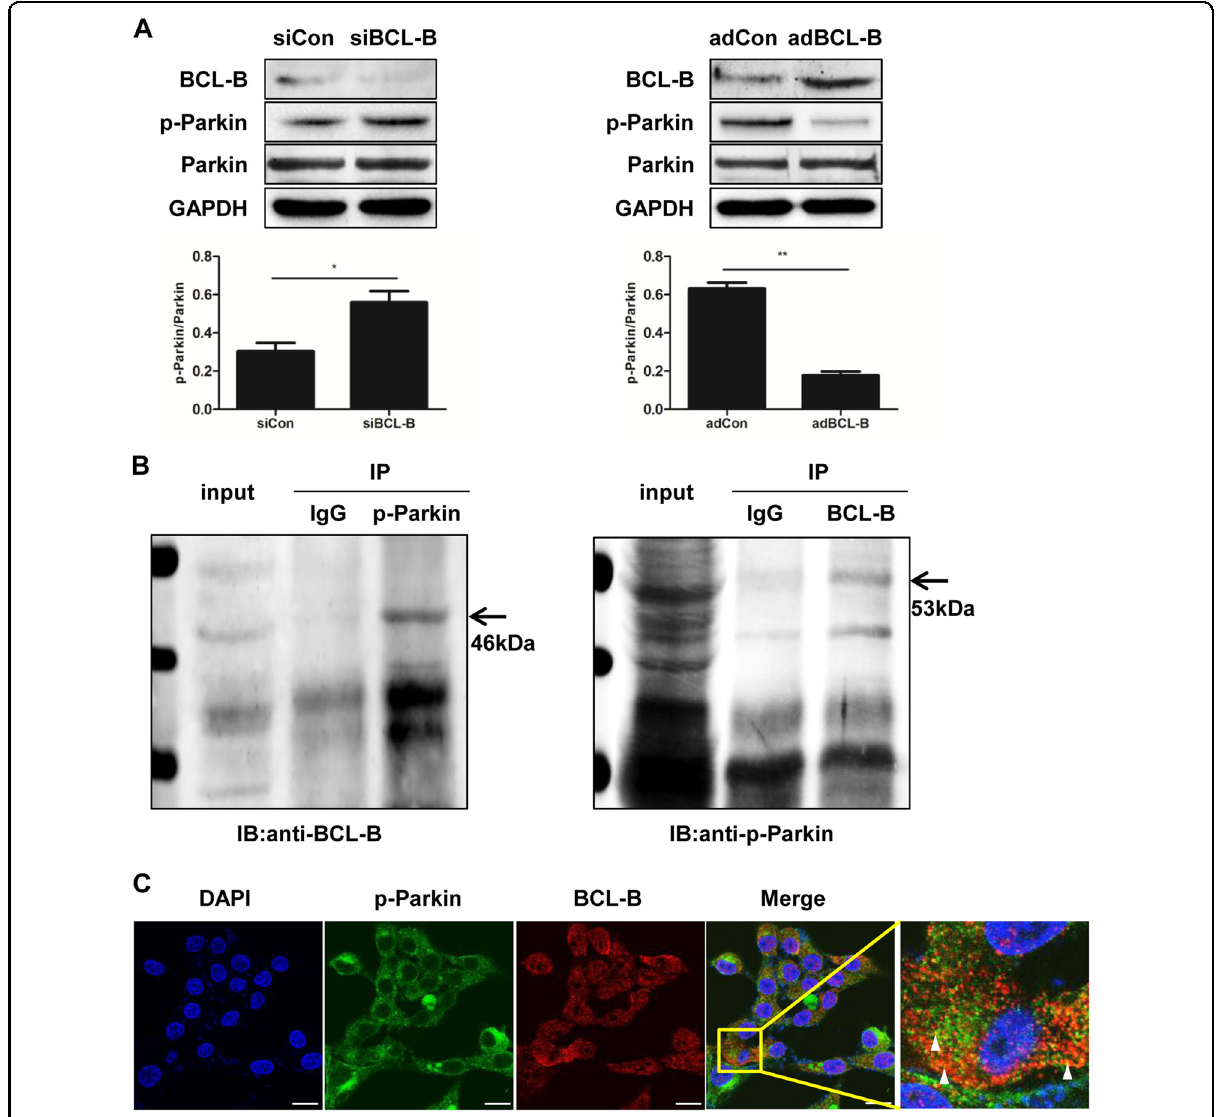
Fig. 7 BCL-B inhibits mitophagy by binding phospho-Parkin. a Representative western blots of BCL-B, p-Parkin and Parkin in LX2 cells. Bar graph represents the mean ± SEM of three different experiments. * P < 0.05 and ** P < 0.01 vs. the indicated groups. b Co-immunoprecipitation of the interaction between p-Parkin and BCL-B in LX2 cells. c Immuno fl uorescence staining of p-Parkin (green) and BCL-B (red) in LX2 cells. The nuclei were stained with DAPI (blue). Scale bar, 10 μ